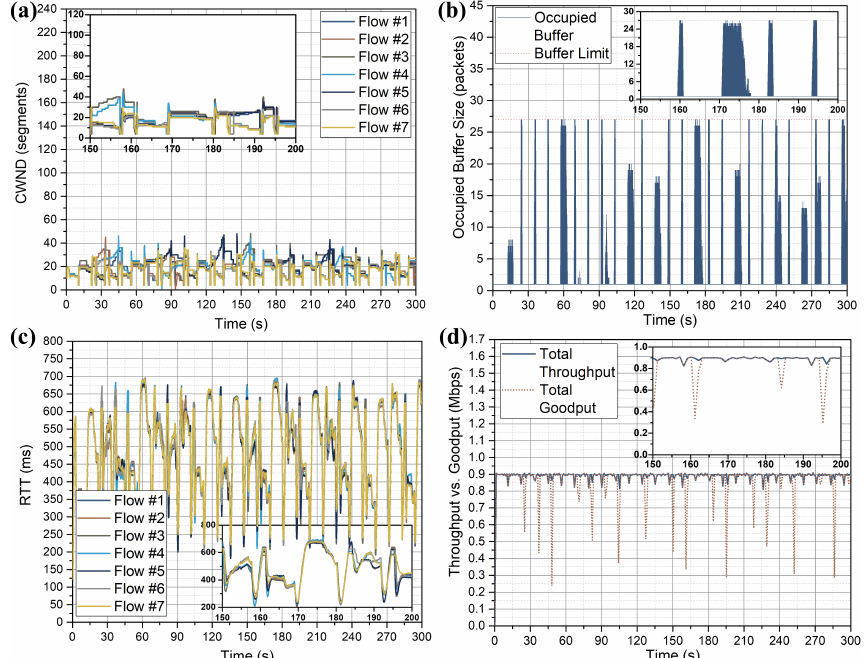
Figure 10. In the simulation experiment, the performance of BBR-ACD in terms of ( a ) congestion window (CWND), ( b ) occupied buffer size, ( c ) round trip time (RTT), and ( d ) throughput vs. goodput.